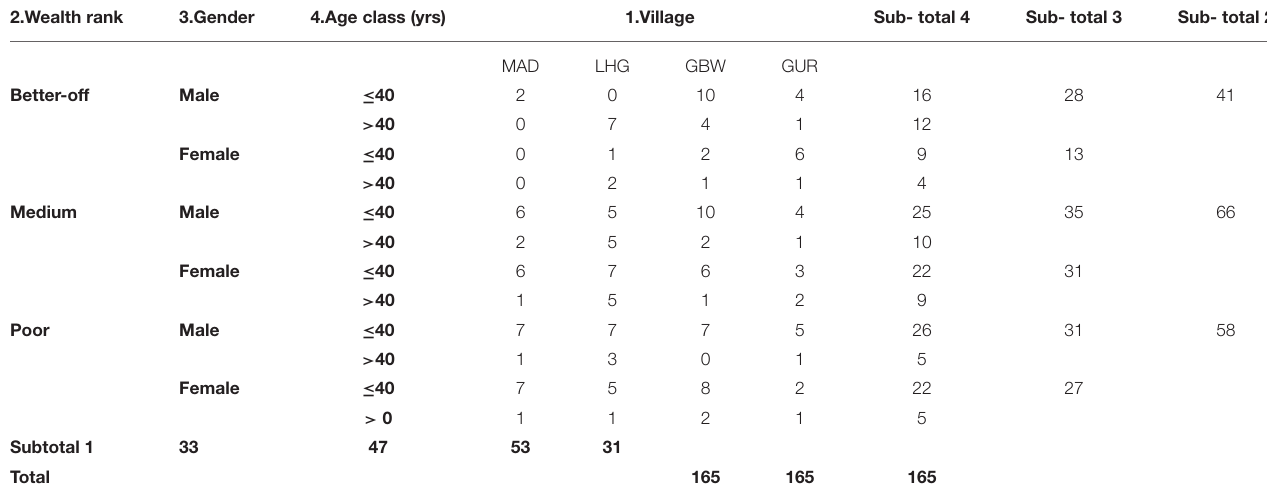
TABLE 2 | Phase 2 sample-design with respondent numbers cross-tabulated against four background variables.